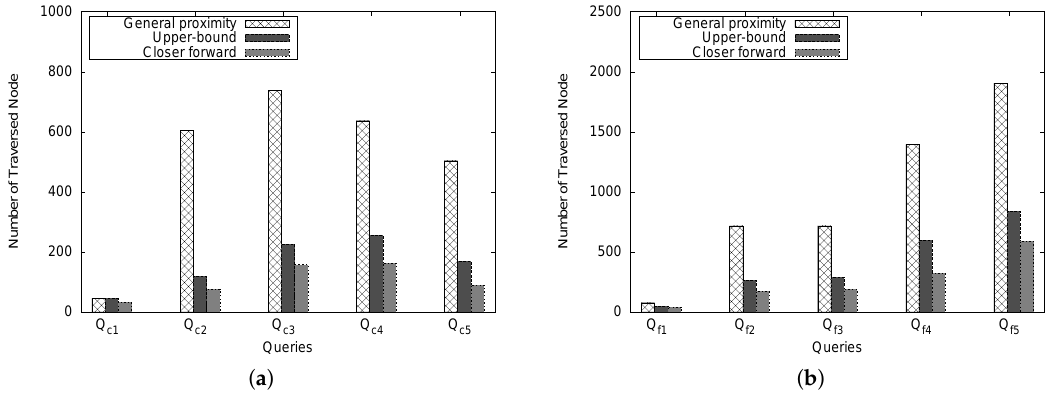
Figure 18. Number of traversed nodes for general cases. ( a ) close pair queries; ( b ) far pair